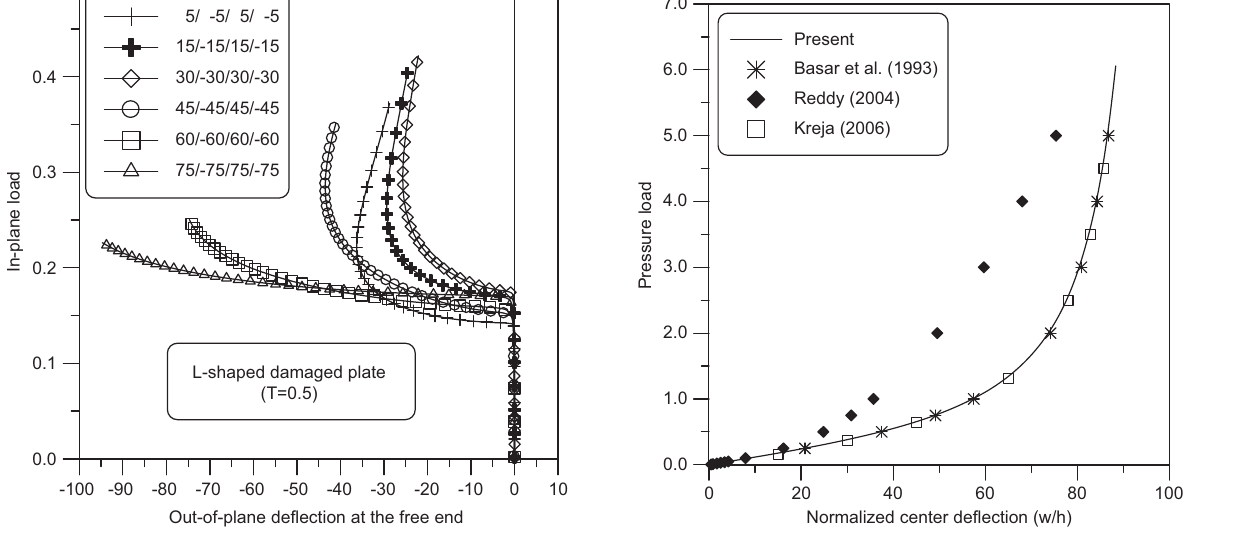
Figure 9 Load-defl ection curve of laminated composite plate under pressure